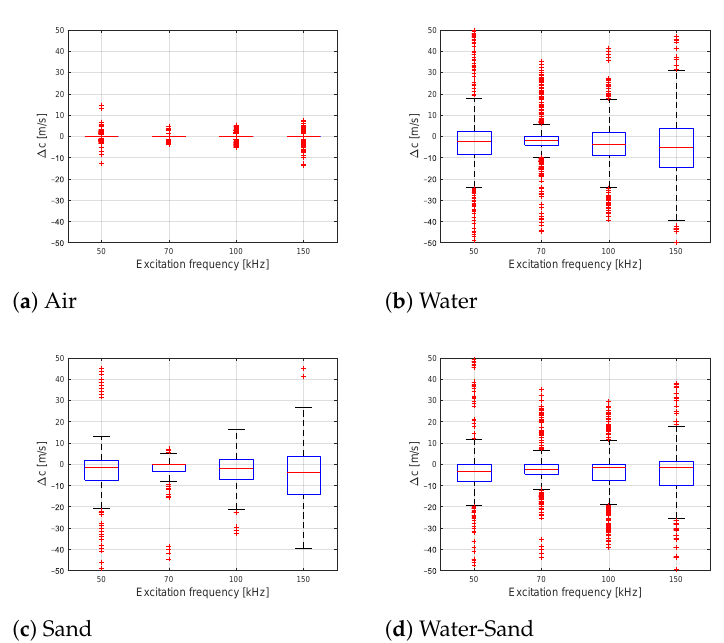
Figure A1. Change of the estimated group velocities ∆ c for all acquired experimental data compared to its reference. The data contains all measured circumferential FA-L(0,1) of ring number one and specified for each excitation frequency separately. Additionally, the data are selected for propagation paths solely along the given phase (air, water or sand) or phase transition (water-sand).